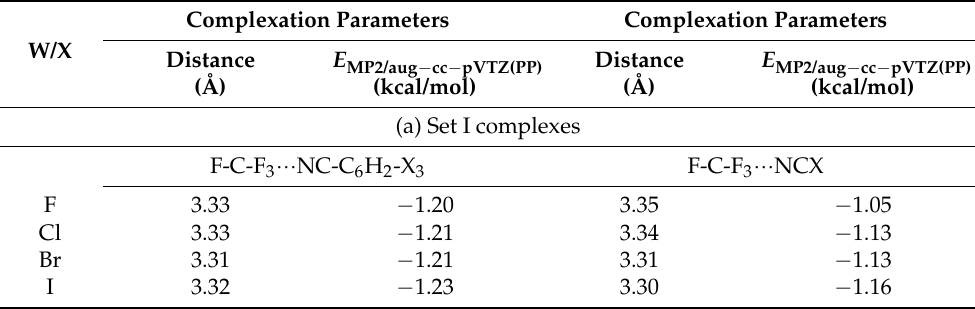
Figure 4. ( a ) Set I and ( b ) Set II complexes elucidating the Lewis basicity and acidity effects, respec- tively. The C∙∙∙N distances are evaluated in Å. Table 2. Interaction energies ( E int , in kcal/mol) for (a) Set I and (b) Set II complexes were evaluated at the MP2/aug-cc-pVTZ(PP) level of theory.